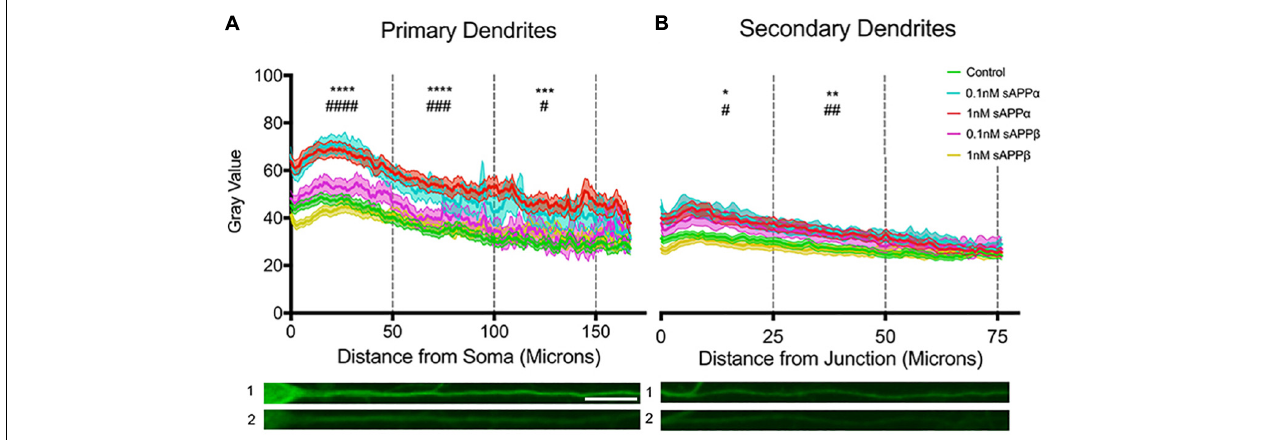
FIGURE 5 | Arc protein expression increases throughout primary and secondary dendrites. Average fluorescent intensity of Arc expression throughout (A) primary and (B) secondary dendrites (mean ± SEM, n = 40–141). Significance was determined by averaging dendritic gray value within each cell and is expressed per treatment group within (A) 50 and (B) 25 microns. Asterisks ( ∗ ) and hashes (#) indicate significance found between 1 and 0.1 nM sAPP α , respectively, relative to controls. Representative fluorescence images illustrate Arc protein expression (green) within primary (A1,2) and secondary (B1,2) dendrites in the presence of 1 nM sAPP α (A1,B1) or no drug (A2,B2). Significance was determined by Kruskal–Wallis One-Way ANOVA and Dunn’s multiple comparisons test. ∗ / # p = ≤ 0.05 ∗∗ / ## p = ≤ 0.005, ∗∗∗ / ### p = 0.0005, ∗∗∗∗ / #### p = ≤ 0.0001. Scale bar = 50 µ